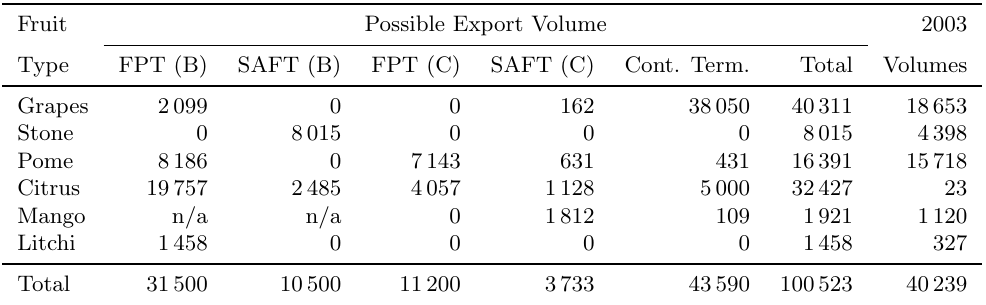
The maximum possible flow of fruit (in pallets per week) through the South African fruit export infrastructure in summer, assuming that the port of Cape Town is the only point of exit from the export infrastructure. Legend: B = Break-bulk, C = Containerised, n/a = not allowed, Cont. Term. = Container